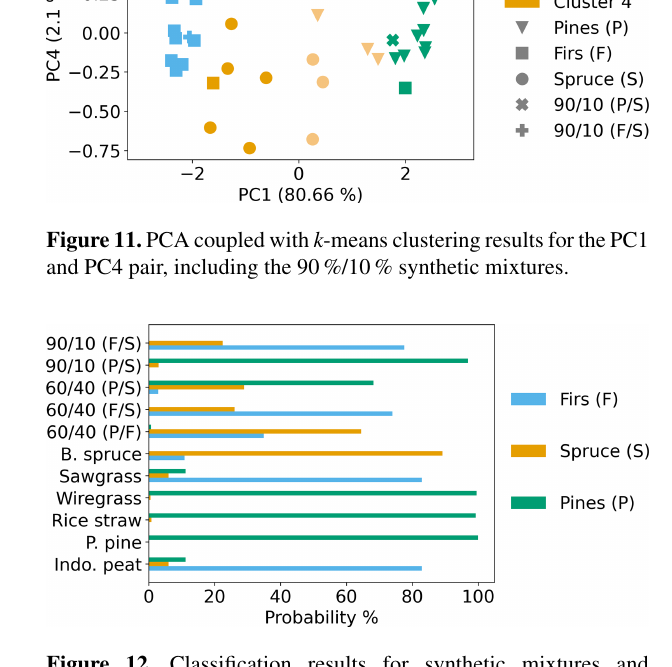
Figure 12. Classification results for synthetic mixtures and FLAME-4